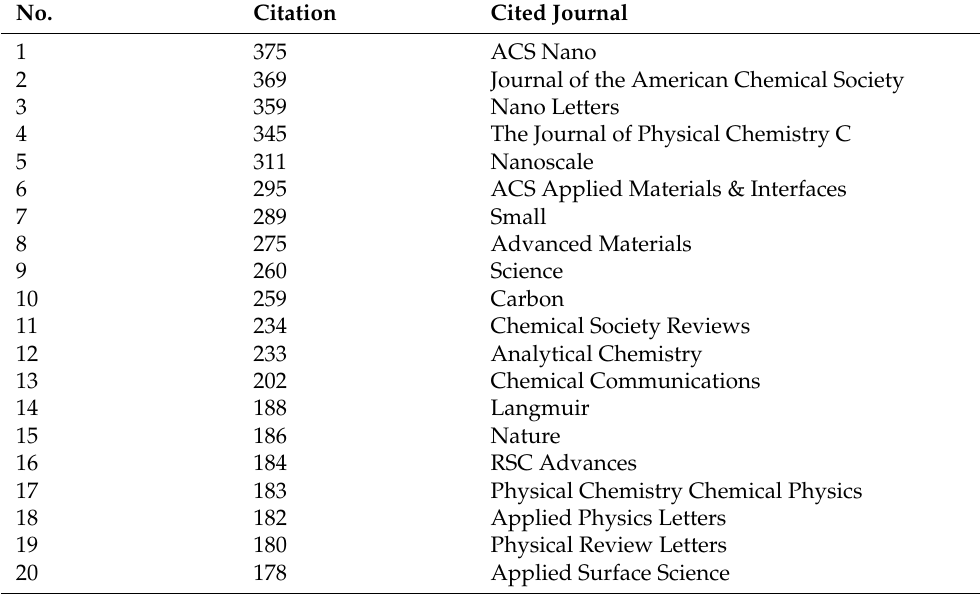
Table 1. The top 20 cited journals on the graphene-based SERS.